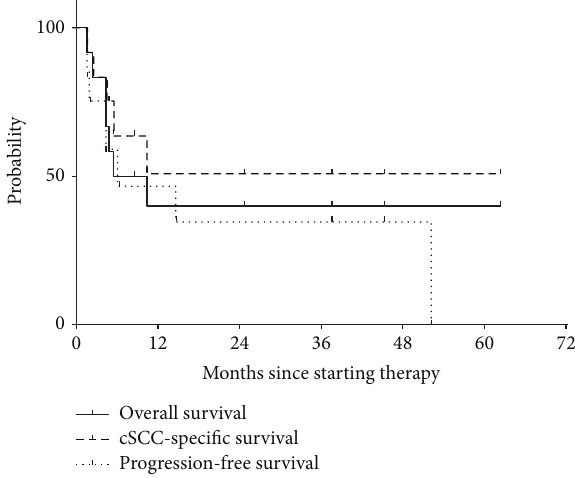
Figure 2: Overall, disease-specific, and progression-free survival. Median progression-free and overall survival were 6.4 and 8.0 months, respectively. Median cutaneous squamous cell carcinoma- (cSCC-) specific survival was not reached. cSCC-specific and overall survival were 51% (95% confidence interval, 26–85%) and 40% (95% confidence interval, 14–66%) at 2